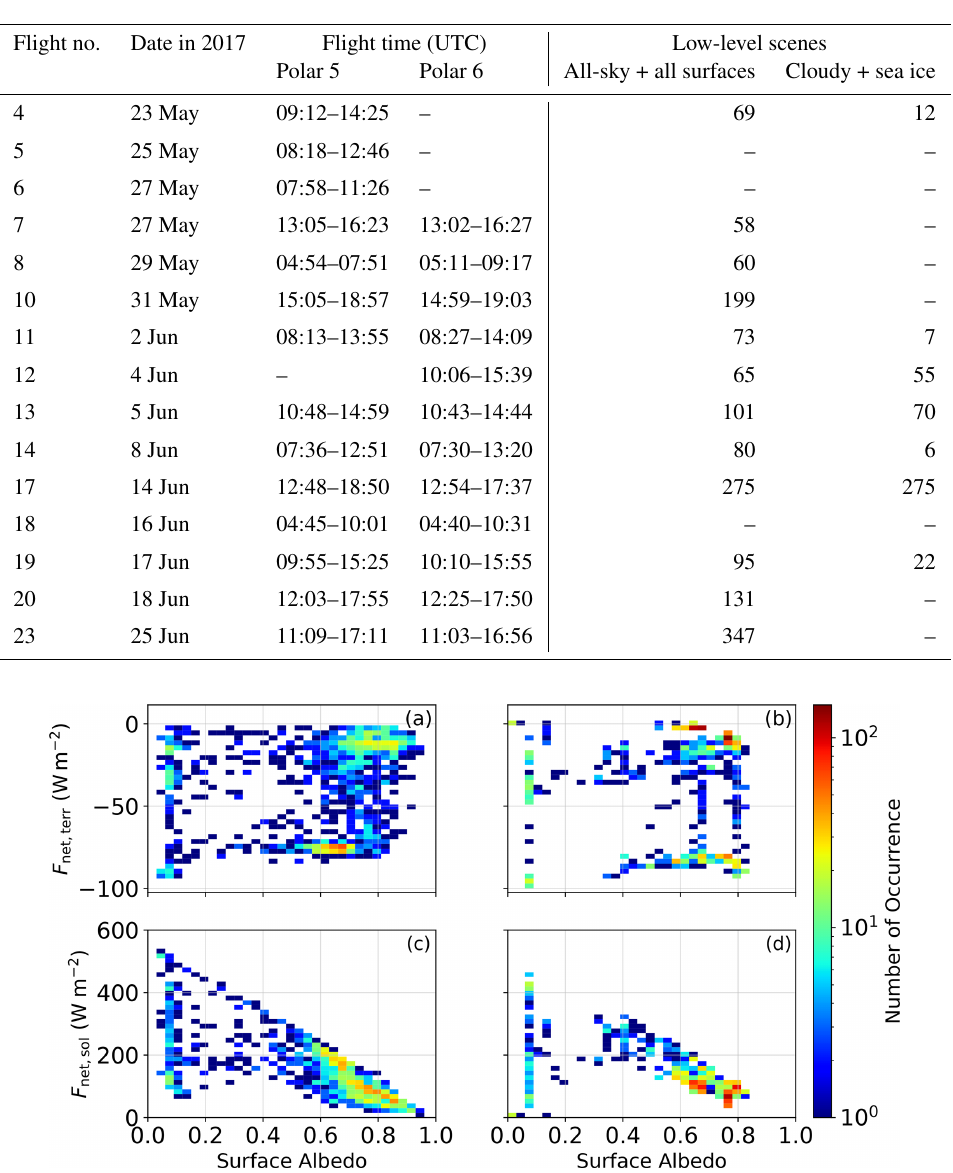
Figure 2. Two-dimensional histograms of surface albedo and (top row; a, b ) net terrestrial irradiance (bottom row; c, d ) net solar irradiance at the surface (Wm − 2 ) for (left column; a, c ) ACLOUD observations and (right column; b, d ) ICON